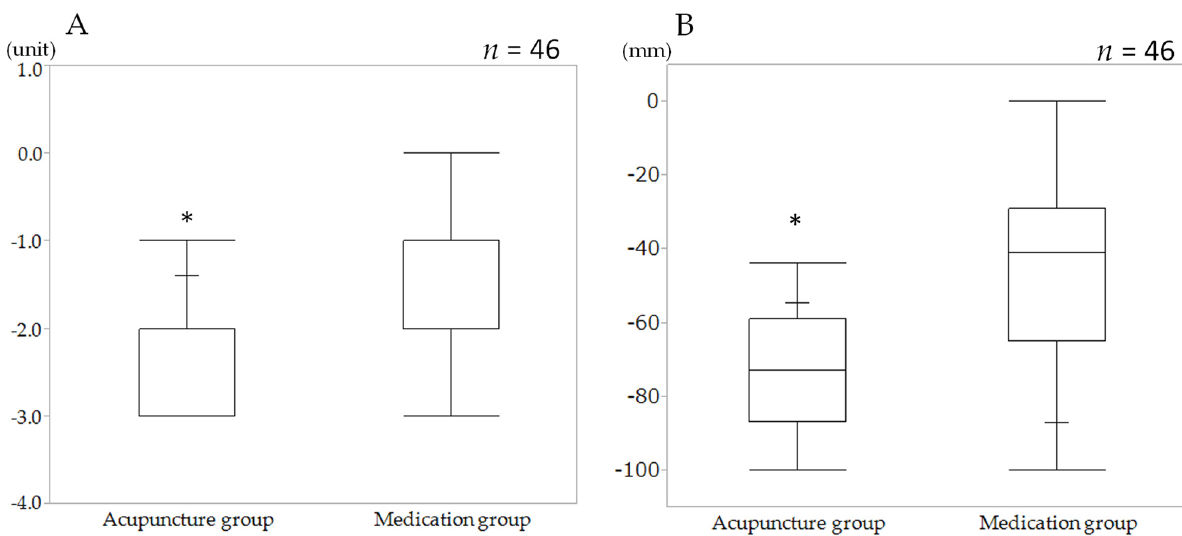
Figure 3. The difference in the antispasmodic action of the upper gastrointestinal tract before and after medication and acupuncture. ( A ) Modified NIWA classification. ( B ) Visual analogue scale. The bottoms and tops of the white boxes represent the 25th and 75th percentiles, respectively, and the lines in the middles represent the 50th percentiles (medians). The whiskers (lines that extend out of the tops and bottoms of the black boxes) represent the highest and lowest values within 1.5 times the interquartile range. * p < 0.0001, Mann–Whitney test. Visual analogue scale (VAS). Table 4. Changes in the other outcome and procedure